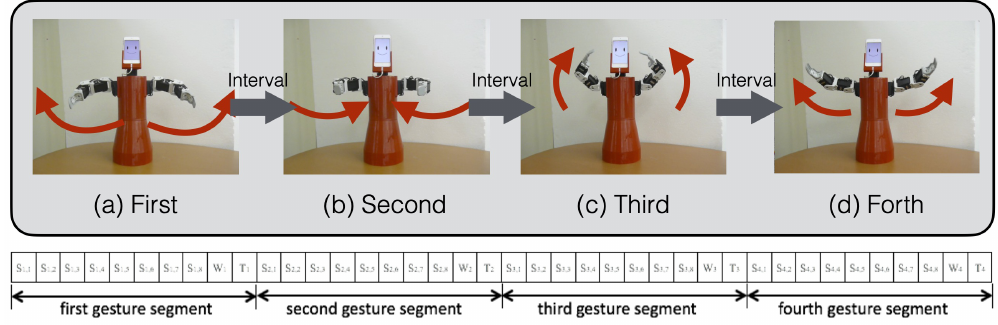
Figure 9. Segment of robot movements for gesture generation.